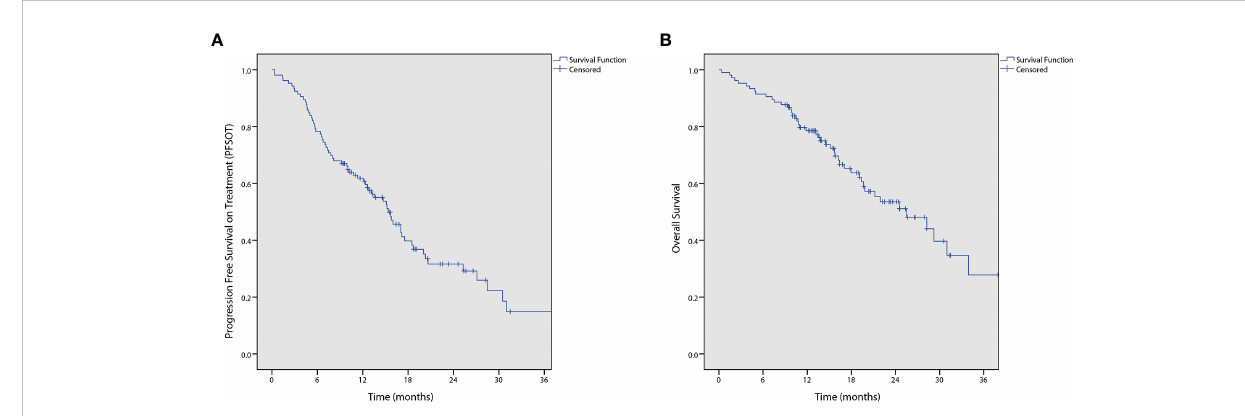
FIGURE 1 Kaplan-Meier curves of (A) progression free survival on treatment (PFSOT) and (B) overall survival (OS).